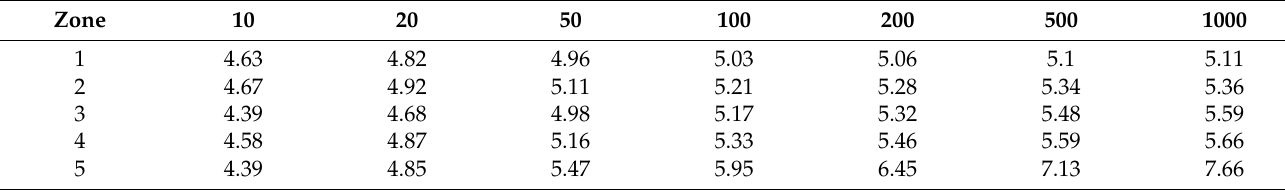
Table 13. Earthquake magnitude return level in Cluster Type I.